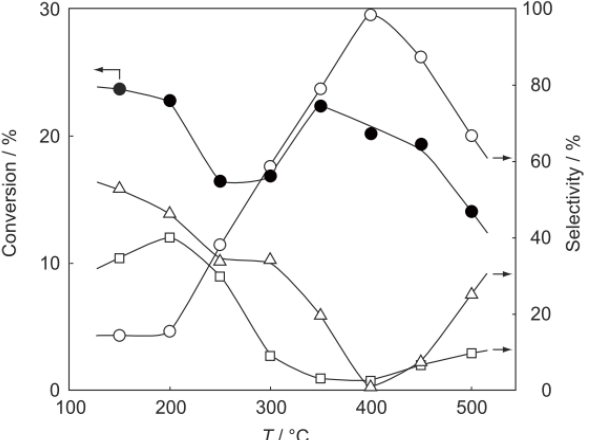
Figure 19. Effect of temperature on the S -methylation of benzenethiol with methanol over [(Nb Cl )Cl (H O) ]·4H O/SiO . Following the activation of the supported cluster (10 mg, 6 12 2 2 4 2 2 0.42 μmol) in a hydrogen stream (300 mL/h) for 1 h, reaction was initiated by introduction of benzenethiol (22 μL/h, 0.20 mmol/h) and methanol (64 μL/h, 2.0 mmol/h) to the stream without changing the temperature. Conversion and selectivities are based on benzenethiol. Conversion of benzenethiol (●); selectivity for methyl phenyl sulfide (○); selectivity for diphenyl sulfide (∆); and selectivity for diphenyl disulfide (□); at 3 h after the start of the